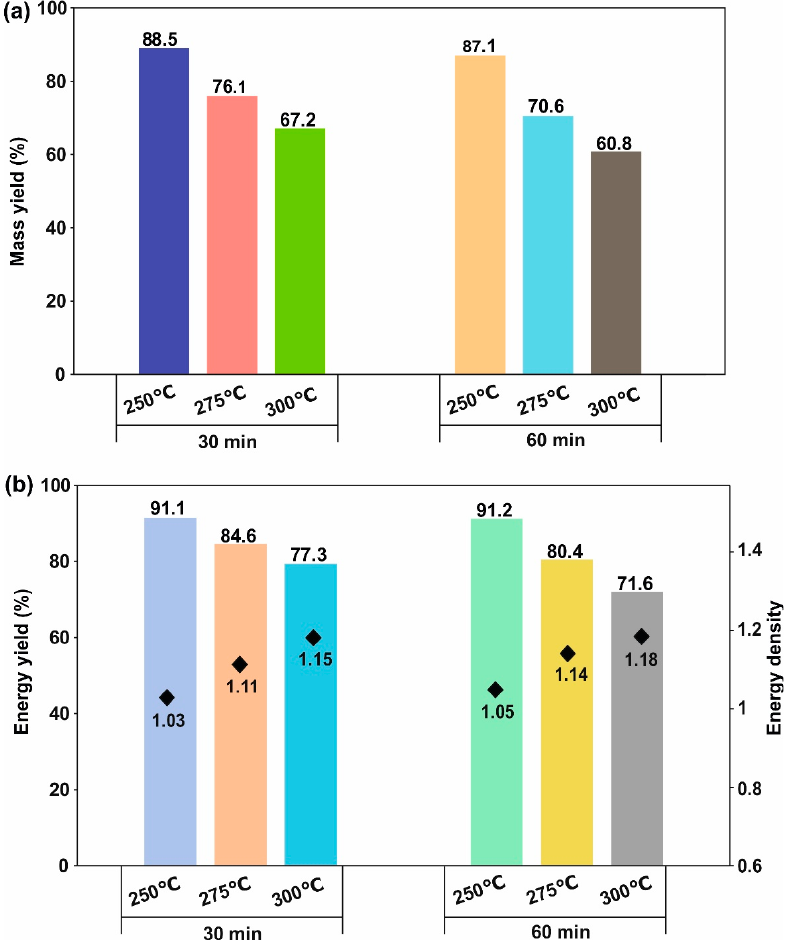
Figure 2. Mass and energy yield during torrefaction of pulp industry sludge; ( a ) Mass yield (wt.%) and ( b ) energy yield (%) and energy density.